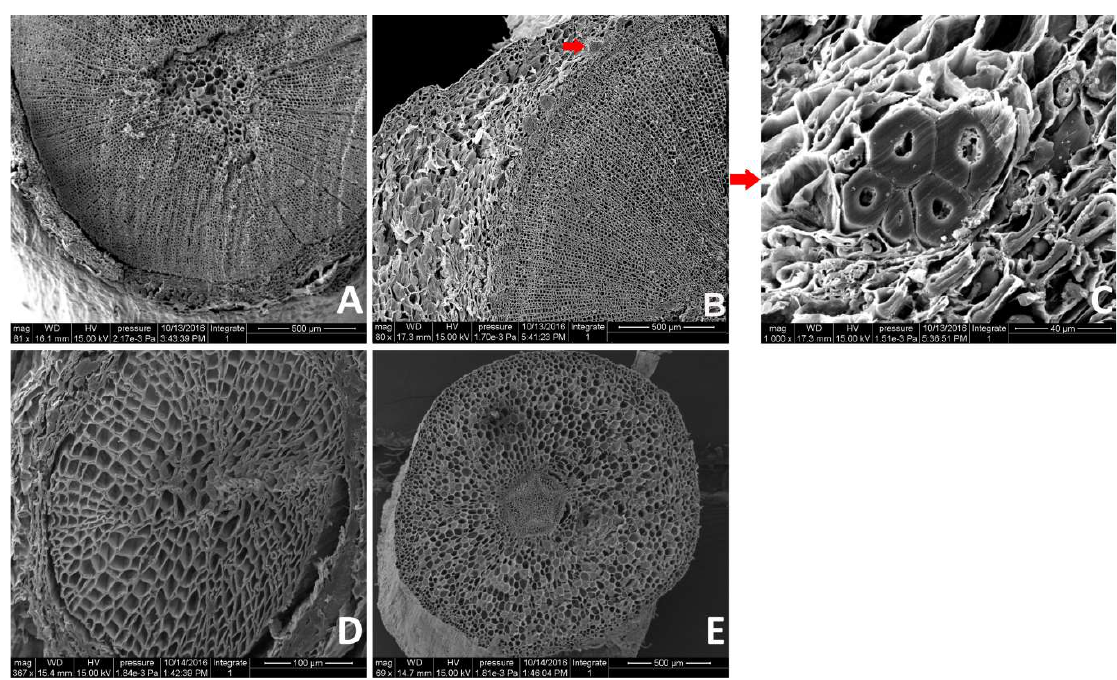
Figure 2. Anatomical changes during AR formation: ( A ) dormant cortex period (S0); ( B ) the initial formation of calli (S1); ( C ) a partial enlarged version of 2B with the root primordium at the intersection of the phloem and cambium (S1); ( D ) the formation of the primary root (S2); and ( E ) the root-elongation period (S3). The two red arrows point to the location of the root primordium.